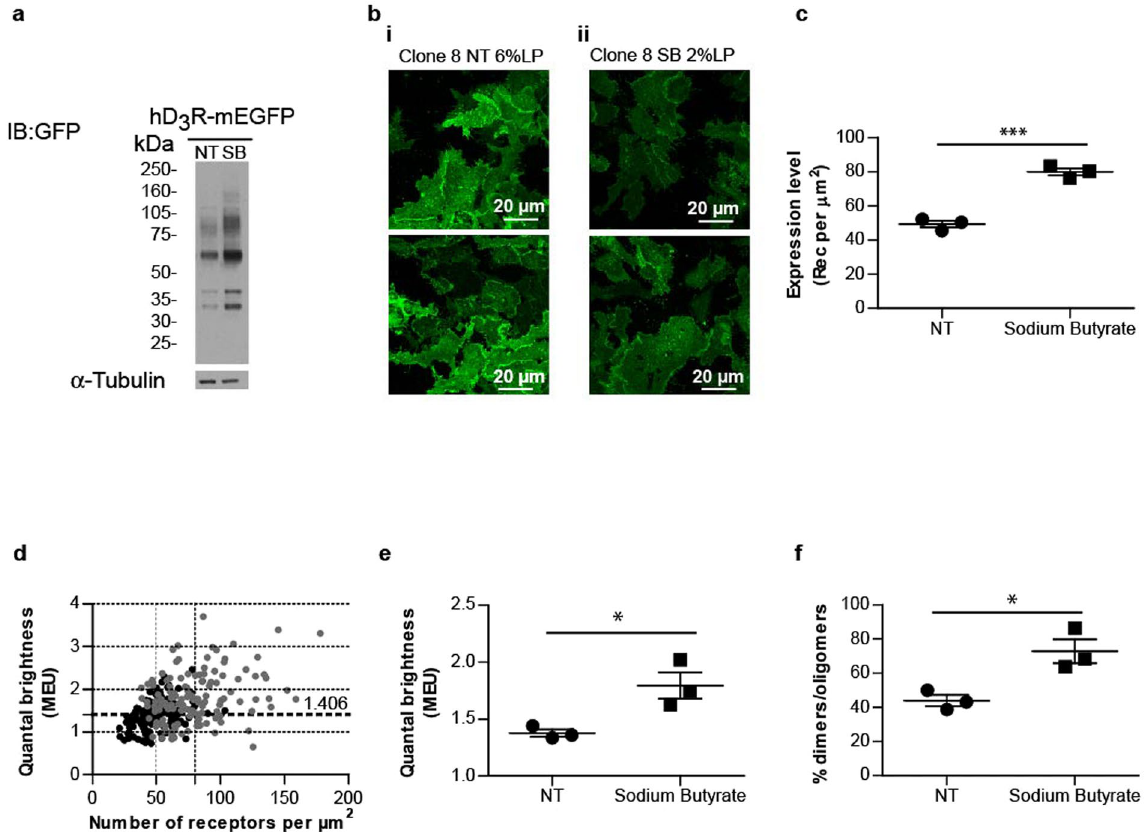
Figure 4. Sodium butyrate increases hD 3 R expression level and oligomeric complexity. Flp-In T-REx 293 hD 3 R-mEGFP clone 8 cells were maintained in the absence (NT) or presence (SB) of 20 mM sodium butyrate for 16 h. ( a ) Lysates from these cells were resolved by SDS-PAGE and immunoblotted with an anti-GFP antiserum ( upper panel ) or an anti- α -tubulin antiserum ( lower panel ). ( b ) Confocal images from the basolateral membrane of these cells were collected with laser power set at 6% ( i ) or 2% ( ii ) respectively. Scale bar = 20 μ m. ( c ). Fluorescence intensity analysis of these images indicated hD 3 R-mEGFP cell surface expression level to be higher in cells treated with sodium butyrate. Combined data from n = 3 × 44 (experiments × observations), with the average value from each experiment shown, error bars represent ± S.E.M. *** p < 0.001 when compared to not treated. ( d ) QB MEU were assessed in individual RoI and plotted against the number of hD 3 R- mEGFP per µ m 2 at the cell surface. Black circles , untreated cells; grey circles , cells treated with 20 mM sodium butyrate. Horizontal dotted line (1.406 MEU), vertical dotted lines provide mean receptor number per μ m 2 for not treated and treated. ( e ) Quaternary arrangement of hD 3 R-mEGFP expressed as QB MEU value in not treated cells (1.38 ± 0.03) and cells treated with sodium butyrate (1.80 ± 0.12). Combined data from n = 3 × 44 (experiments × observations), error bars represent ± S.E.M., * p < 0.05 when compared to not treated. ( f ) Assessment of percentage of RoIs containing predominantly dimers/oligomers in untreated (43.9 ± 3.3%) and sodium butyrate treated (72.7 ± 6.9%) cells. Combined data from n = 3 × 44 (experiments × observations), error bars represent ± S.E.M., * p < 0.05 when compared to not treated